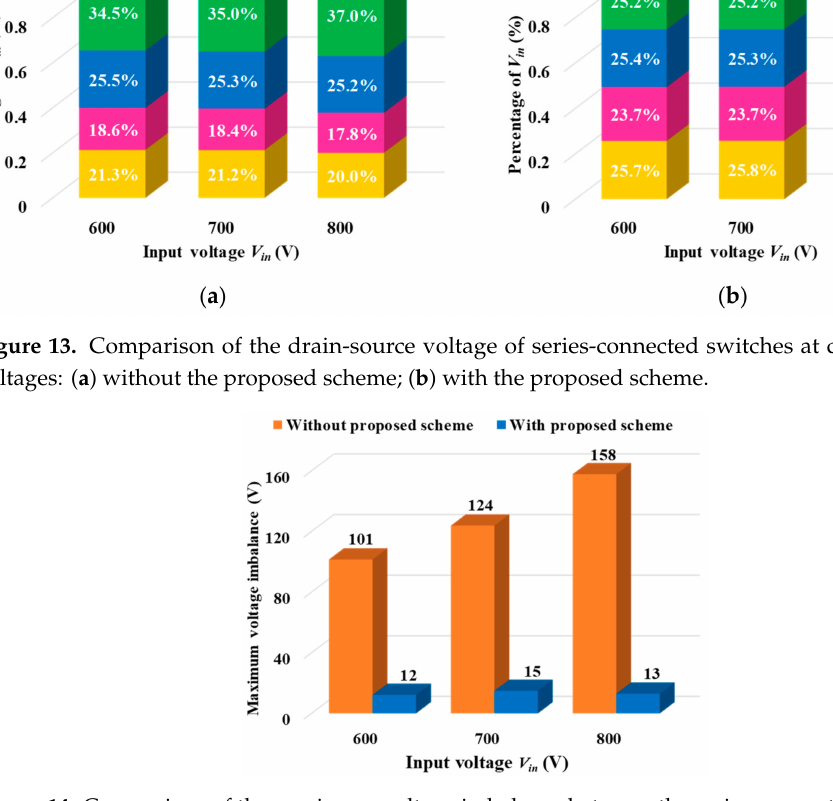
Figure 14. Comparison of the maximum voltage imbalance between the series-connected switches at di ff erent input